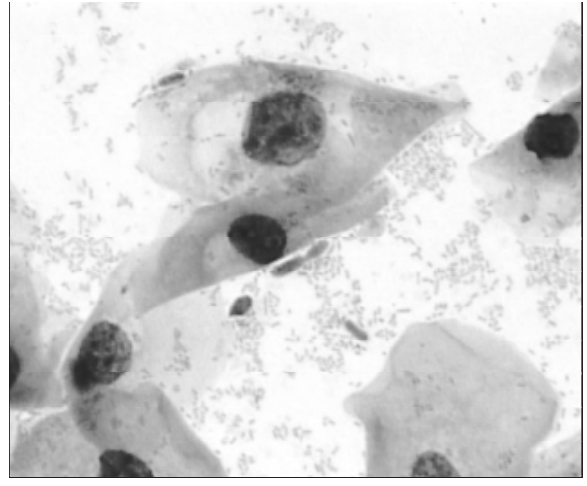
Figura 2 – Anormalidades nucleares em infecções por Candida